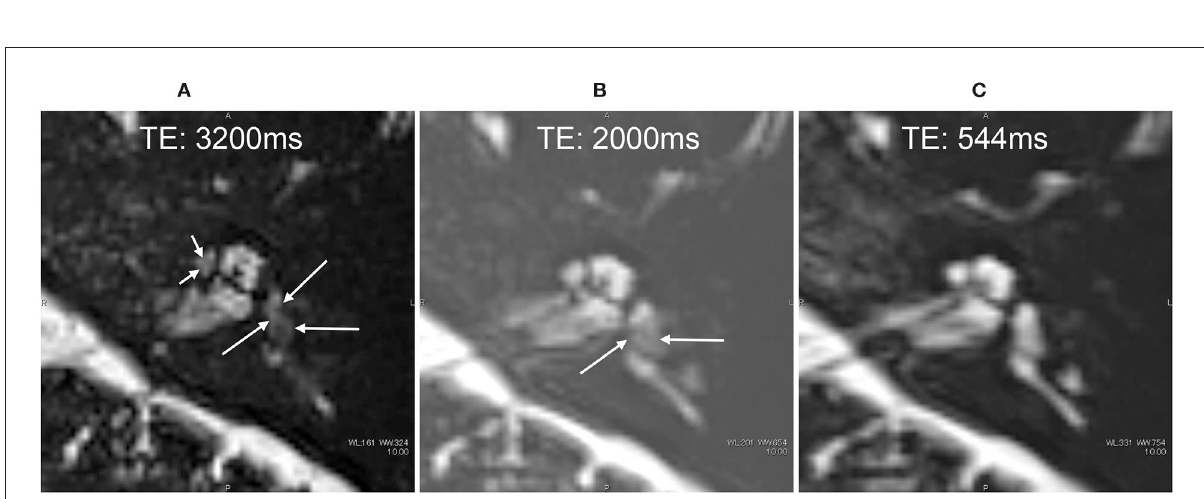
FIGURE6 MR cisternography of the left ear in a 34-year-old male volunteer at the start of the scan. The MR scan was initiated 30min after the intratympanic administration of 17 O-labeled saline (A–C) . Images were obtained serially in the order of (A – C) . In the image with an echo time (TE) of 3,200ms (A) , the signal of the whole vestibule (arrows) decreased because of the highest sensitivity to the T2-shortening effect of 17 O-labeled saline. The anterior part of the cochlea also showed a decreased signal (short arrows). In the image with a TE of 2,000ms (B) , the anatomy of the labyrinth and the contrast between the area with rich 17 O-labeled water distribution (arrows) and that with poor 17 O-labeled water distribution can be seen. In the image with a TE of 544ms (C) , the T2-shortening effect of 17 O-labeled water was almost unrecognizable, and the anatomy of the labyrinth could be